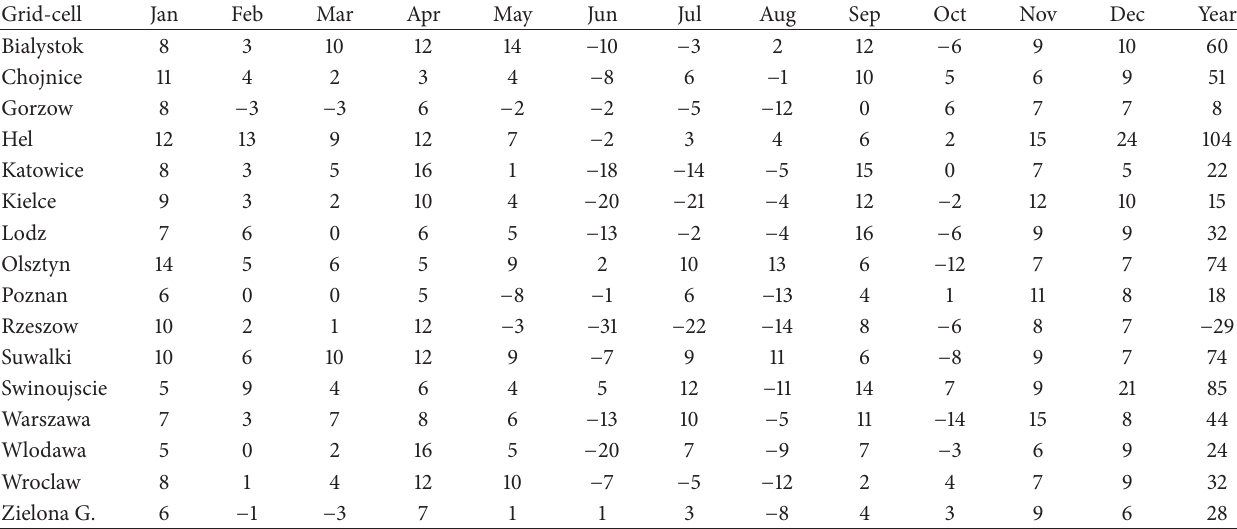
Table 5: The changes of the annual precipitation [in mm] in the future (2061–2090) compared to the control period 1961–1990, based on the MPI-M-REMO